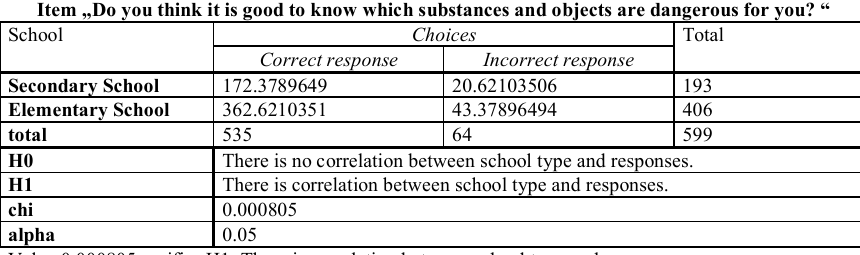
Table 2. Chi-squared test of correlation between school type and responses to „Do you think it is good to know which substances and objects are dangerous for you?